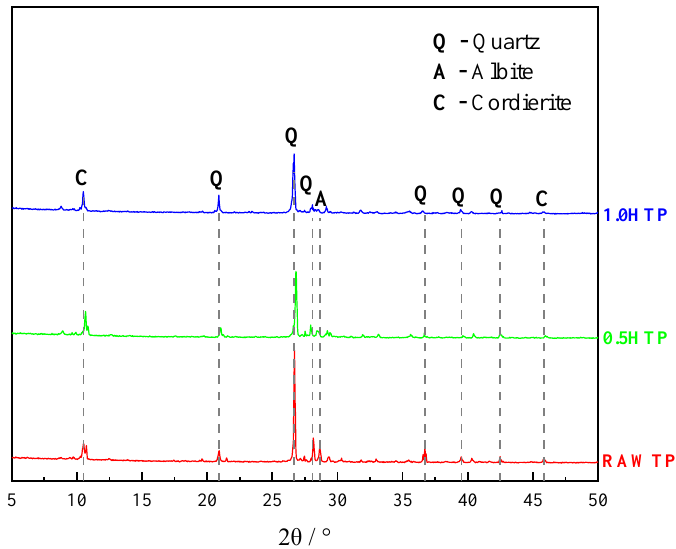
Figure 6. Mineral composition variation of TP during mechanical activation.